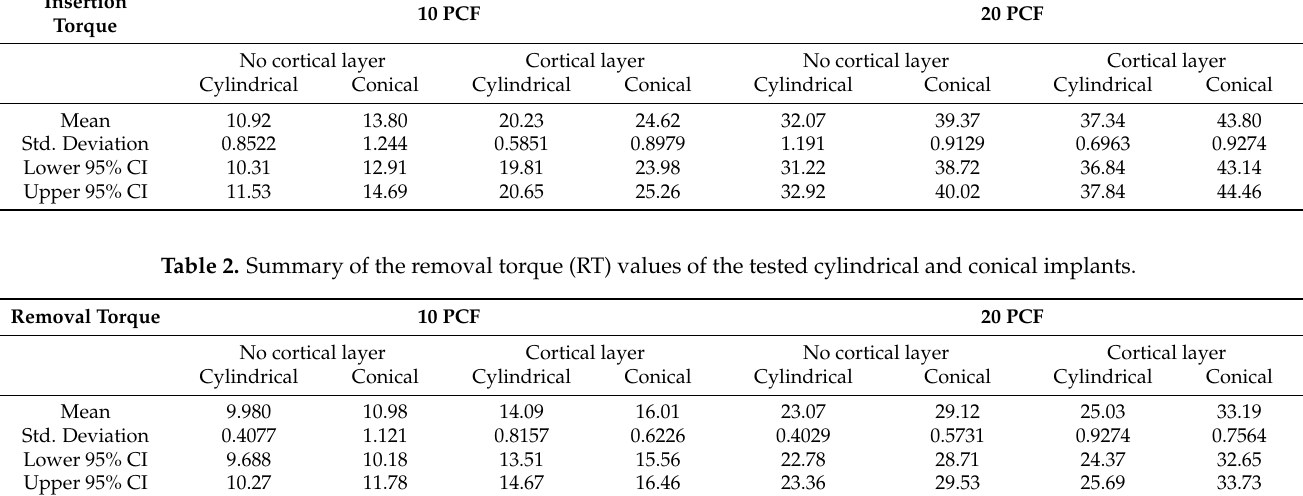
Table 1. Summary of insertion torque (IT) values of the tested cylindrical and conical implants. Table 2. Summary of the removal torque (RT) values of the tested cylindrical and conical implants.